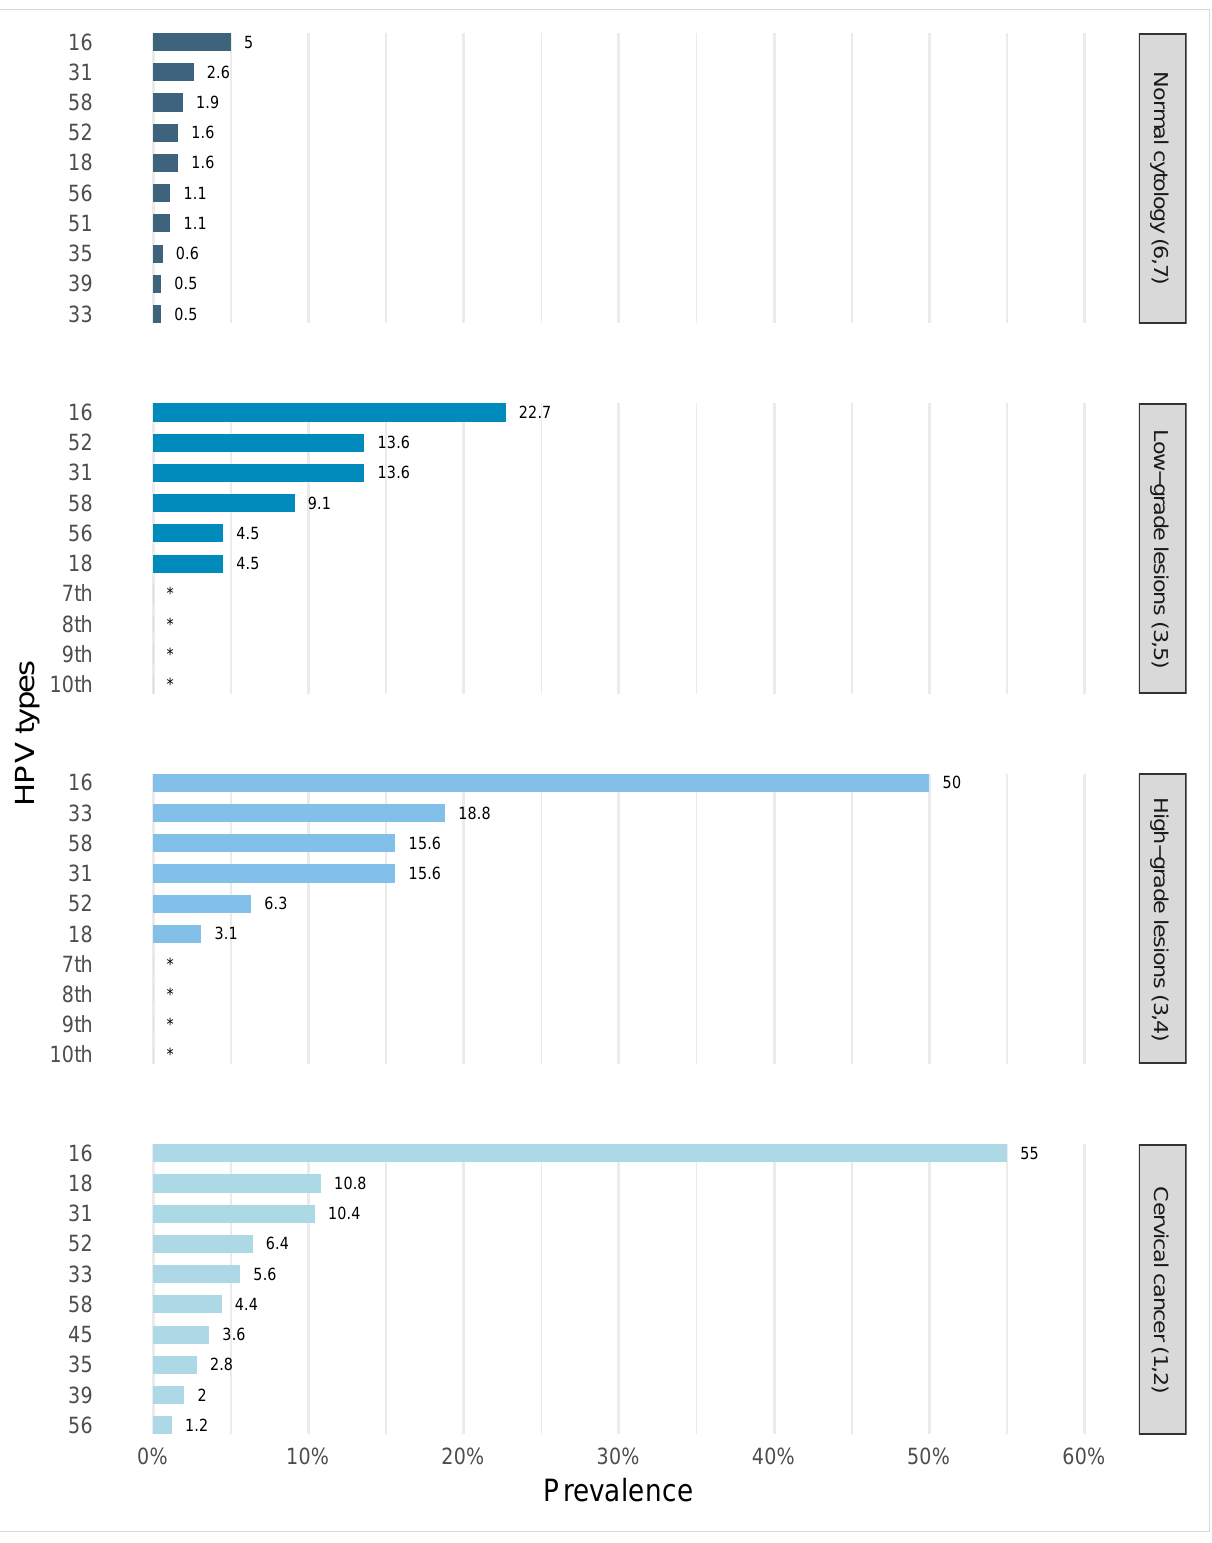
Figure 60: Comparison of the ten most frequent HPV oncogenic types in Peru among women with and without cervical